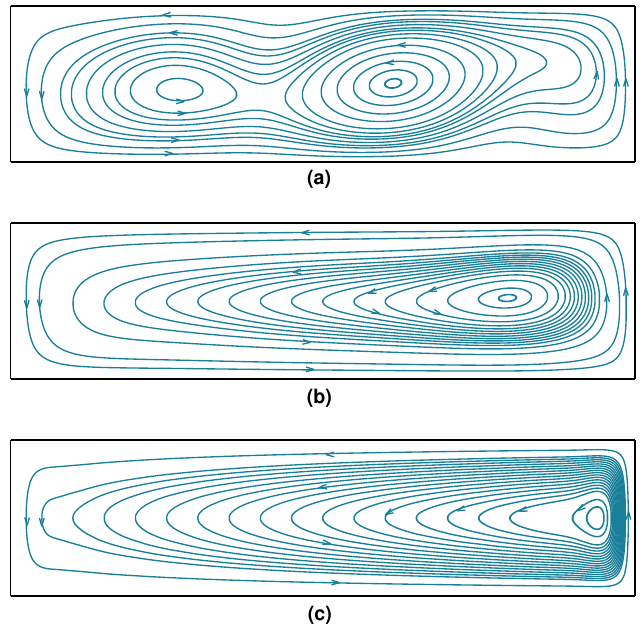
Figure 9. Streamlines for the two-dimensional buoyancy-driven flow problem at Gr = 2 × 10 4 , Ra = 2 × 10 2 . ( a ) Ha = 1; ( b ) Ha = 10; ( c ) Ha = 100.